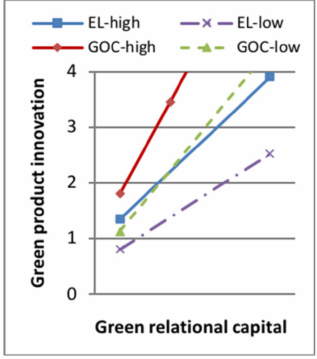
Figure 5. The moderating effect between GRC and